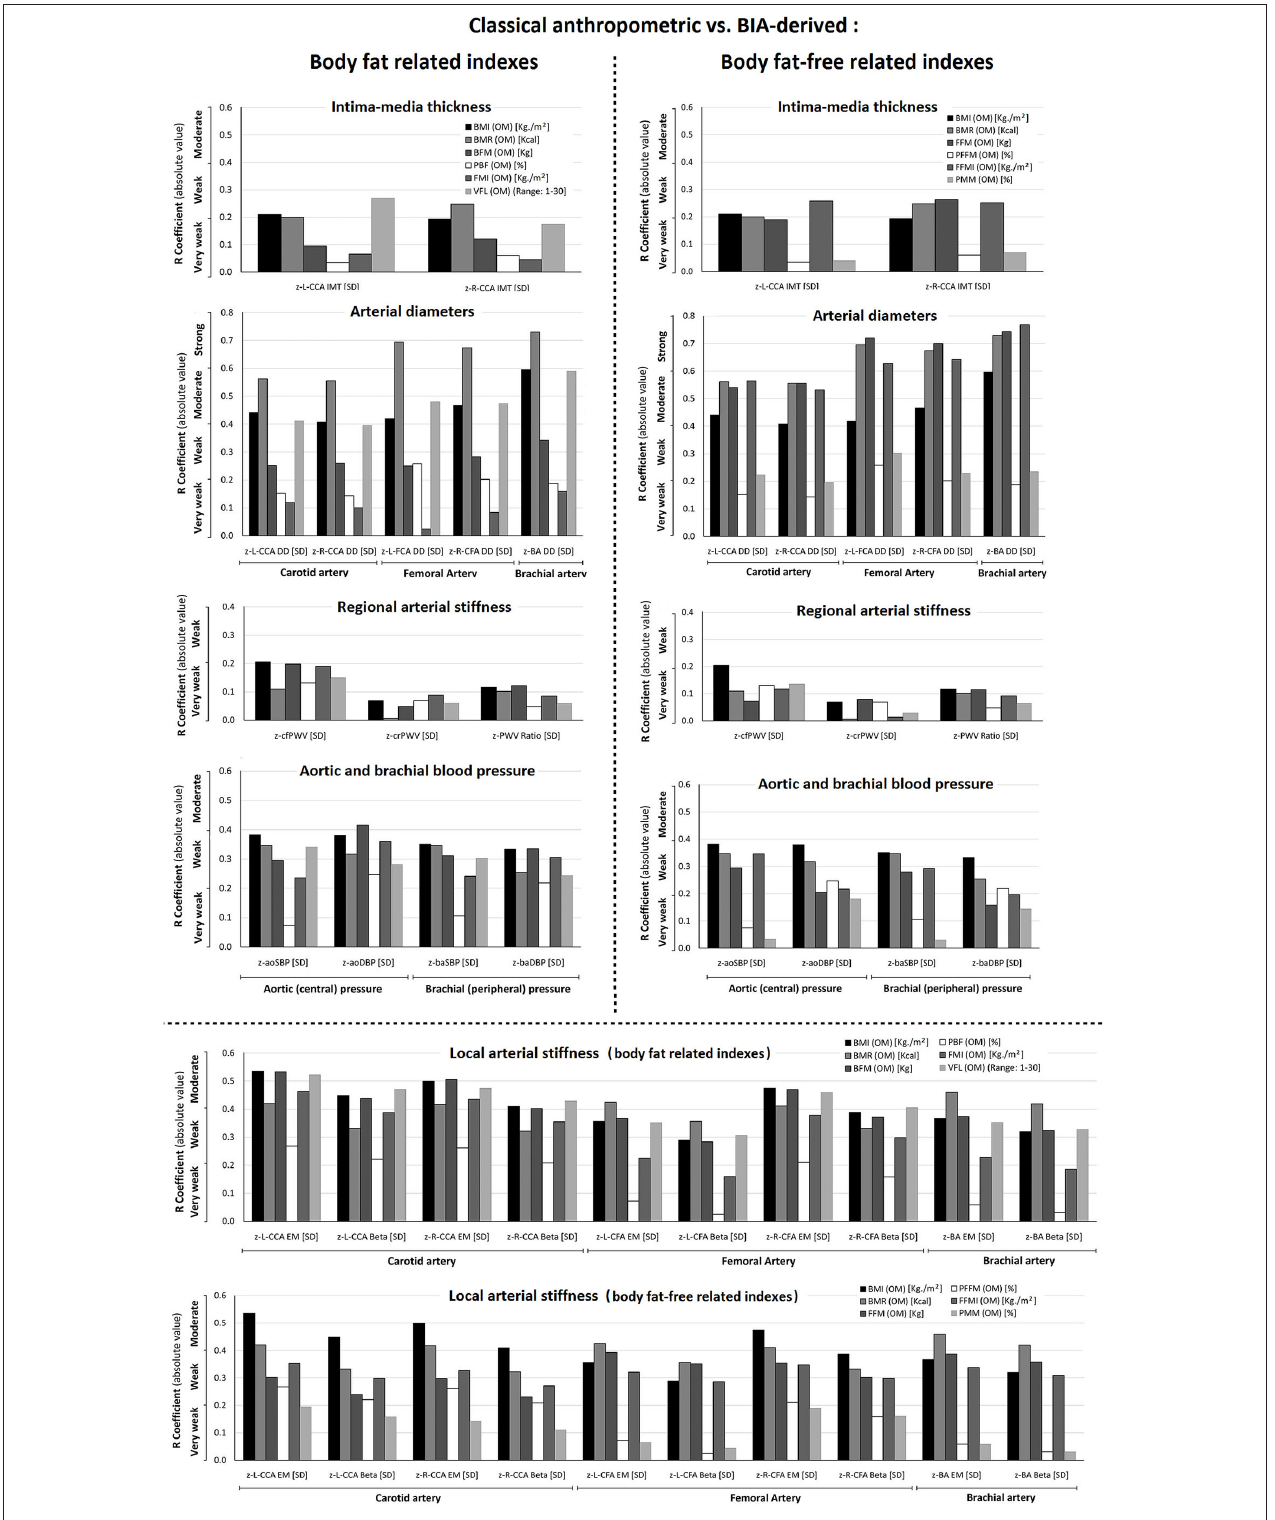
FIGURE 3 | Comparison of the levels of association (r, absolute value) between cardiovascular z-scores and classical anthropometric (BMI, BMR) vs. fat mass indexes (BFM, PBF, FMI, VFL), and classical anthropometric (BMI, BMR) vs. fat-free mass indexes (FFM, PFFM, FFMI, PMM). The variables were obtained with the Omron BIA device (OM). Abbreviations as in